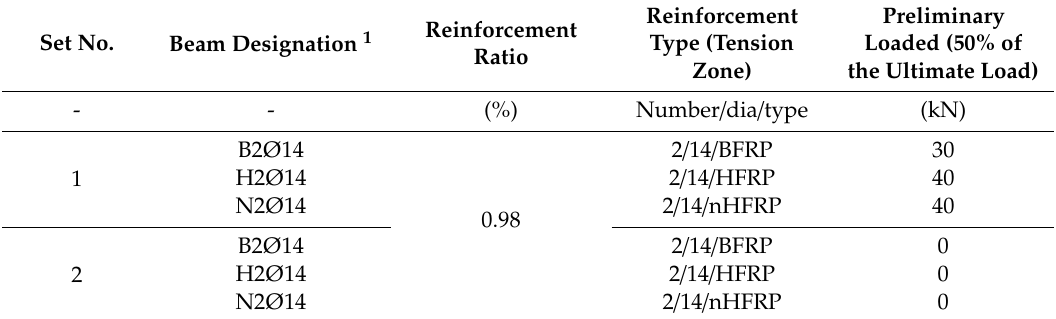
Table 2. Loading and description of specimens. BFRP = basalt fiber-reinforced polymer. Set